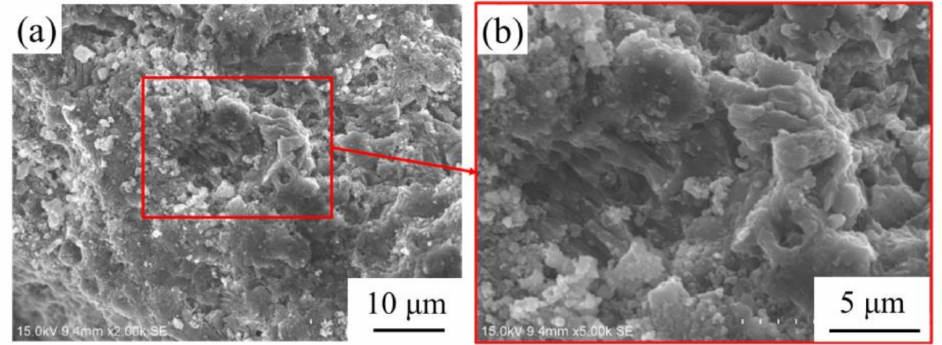
Figure 3. ( a ) Microstructures of coral sand, and ( b ) partial enlarged representation of the red box area in ( a ).